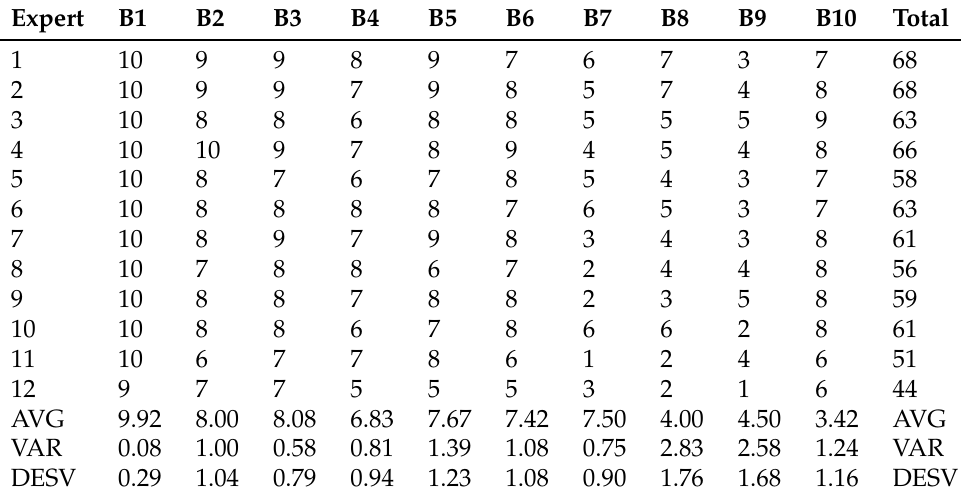
Table 6. Evaluation of the barriers to carpooling from